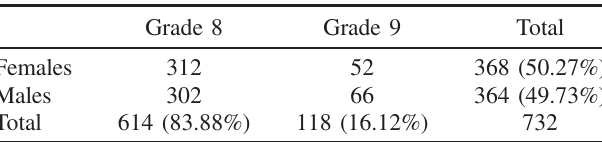
TABLE I. Distribution of the